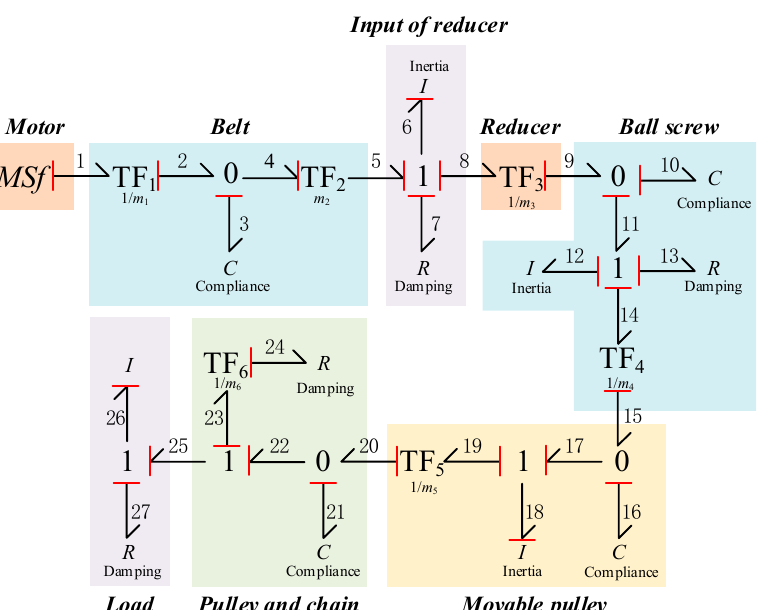
Figure 14. The power bond graph model of ETD.